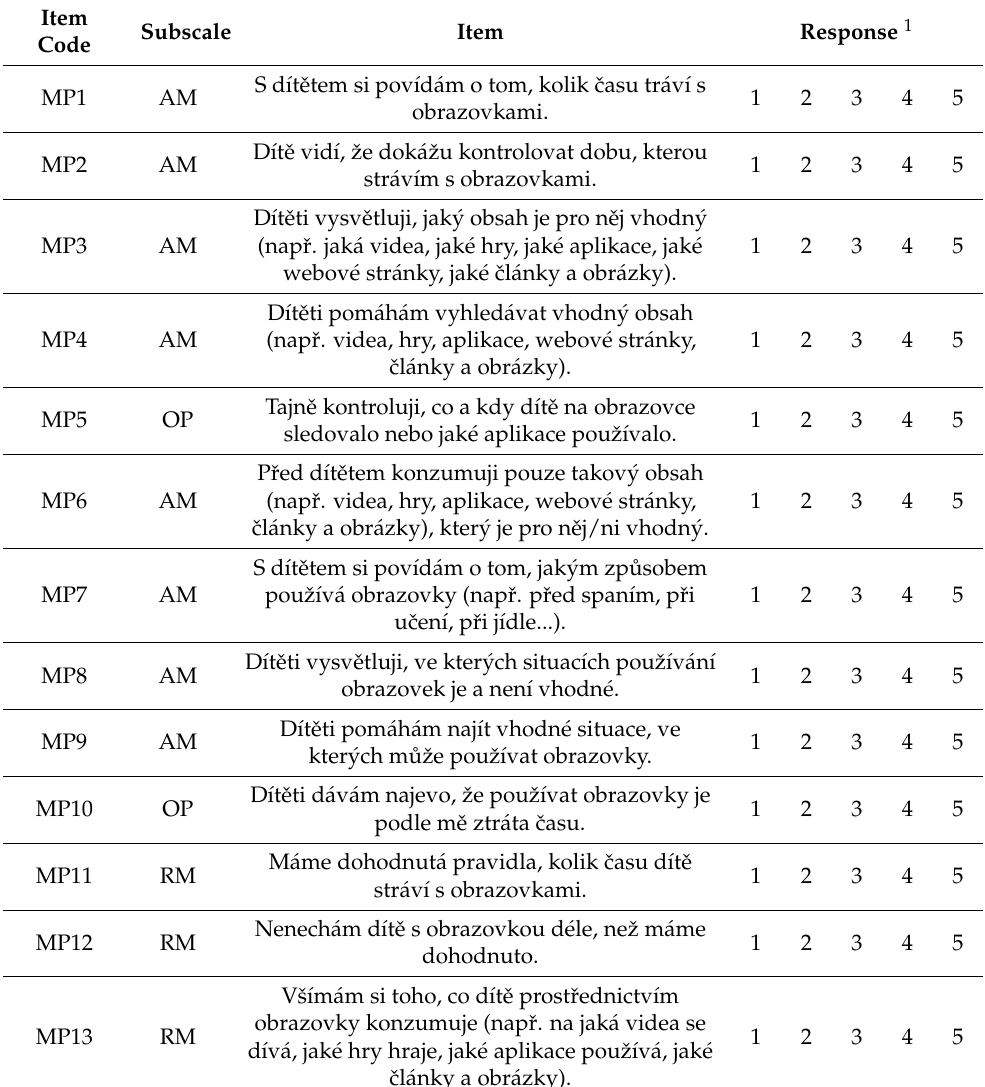
Table A5. MEPA-20: Czech